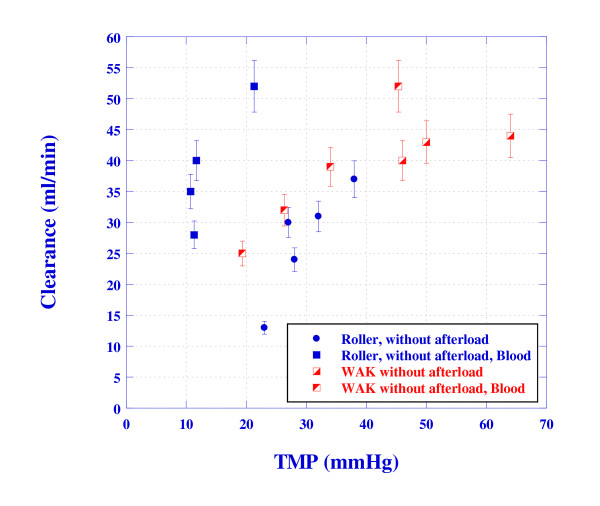
The dependence of the urea clearance on TMP for the WAK and roller pump setups, irrespective of other parameters.